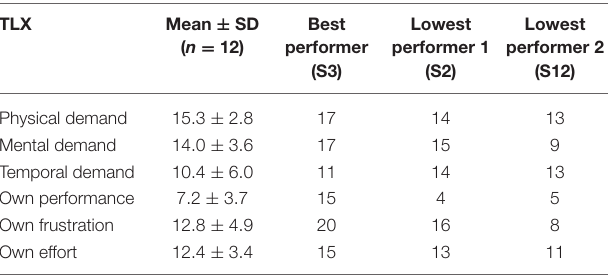
TABLE 3 | NASA task load index (TLX) rates six factors (left column of the table) that are used to assess the subjective workload associated with the experiment. TLX Mean ± SD ( n =